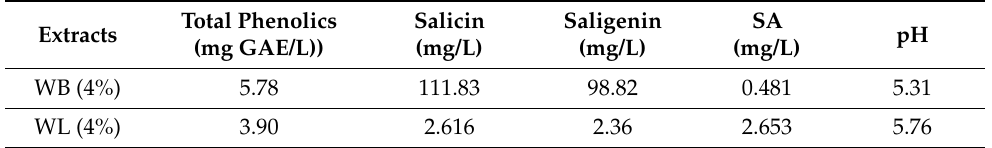
Table 1. Total phenolic, salicylic acid, salicin and saligenin concentrations and pH values of weeping willow ( Salix babylonica ) leaf (WL, 4% w / v ) and bark (WB, 4% w / v ) extracts. Total Phenolics Extracts (mg GAE/L))